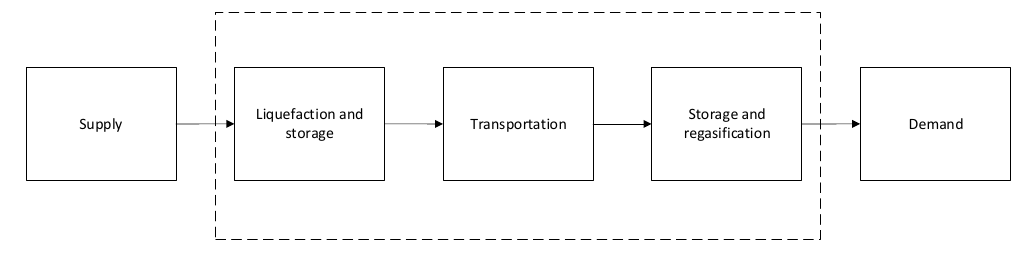
Figure 1. Liquefied natural gas (LNG) supply